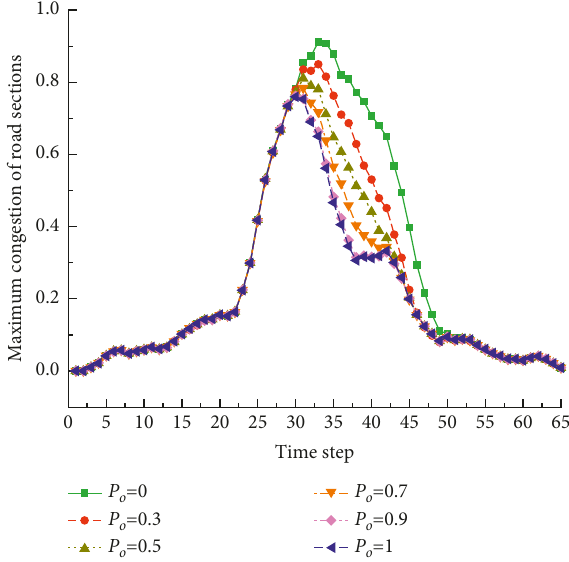
Figure 11: The maximum congestion of road sections under different information obedience rates.